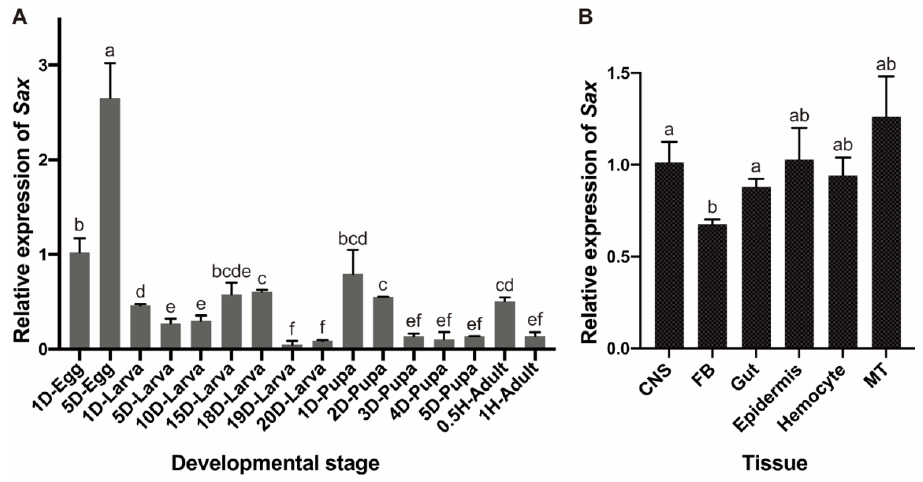
Figure 3. Spatiotemporal expression of Sax in T. castaneum. ( A ) Developmental expression pattern of Sax . The relative expressions of the target transcripts in the 1-day egg served as the calibrator for the developmental expression profiling. ( B ) Tissue-specific expression patterns of Sax in central nervous system (CNS), fat body (FB), gut, epidermis, hemocyte and Malpighian tubule (MT) from 19-day larvae. Different letters on the bars indicate that the means ± SEM are significantly different among treatments by t -test.